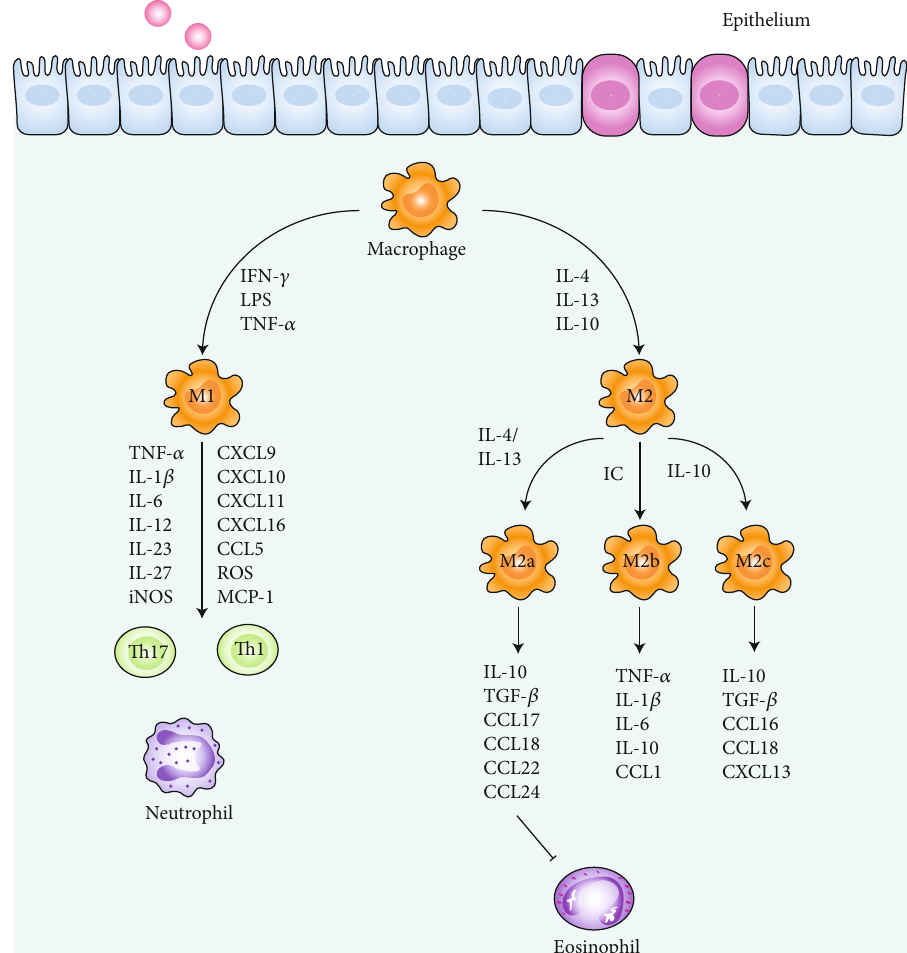
Figure 2: Macrophage dysfunction in asthma pathogenesis. In response to allergens, macrophages di ff erentiate into classically activated (M1) and alternatively activated (M2) macrophages. The arrows refer to the cytokines and chemokines secreted by macrophages, including tumor necrosis factor- (TNF-) α , interleukin (IL), and interferon- (IFN-) γ . M1 macrophages produce T helper (Th) 1-associated and Th17- associated cytokines, a ff ecting the neutrophils. M2 macrophages further di ff erentiate into M2a, M2b, and M2c macrophages, a ff ecting the